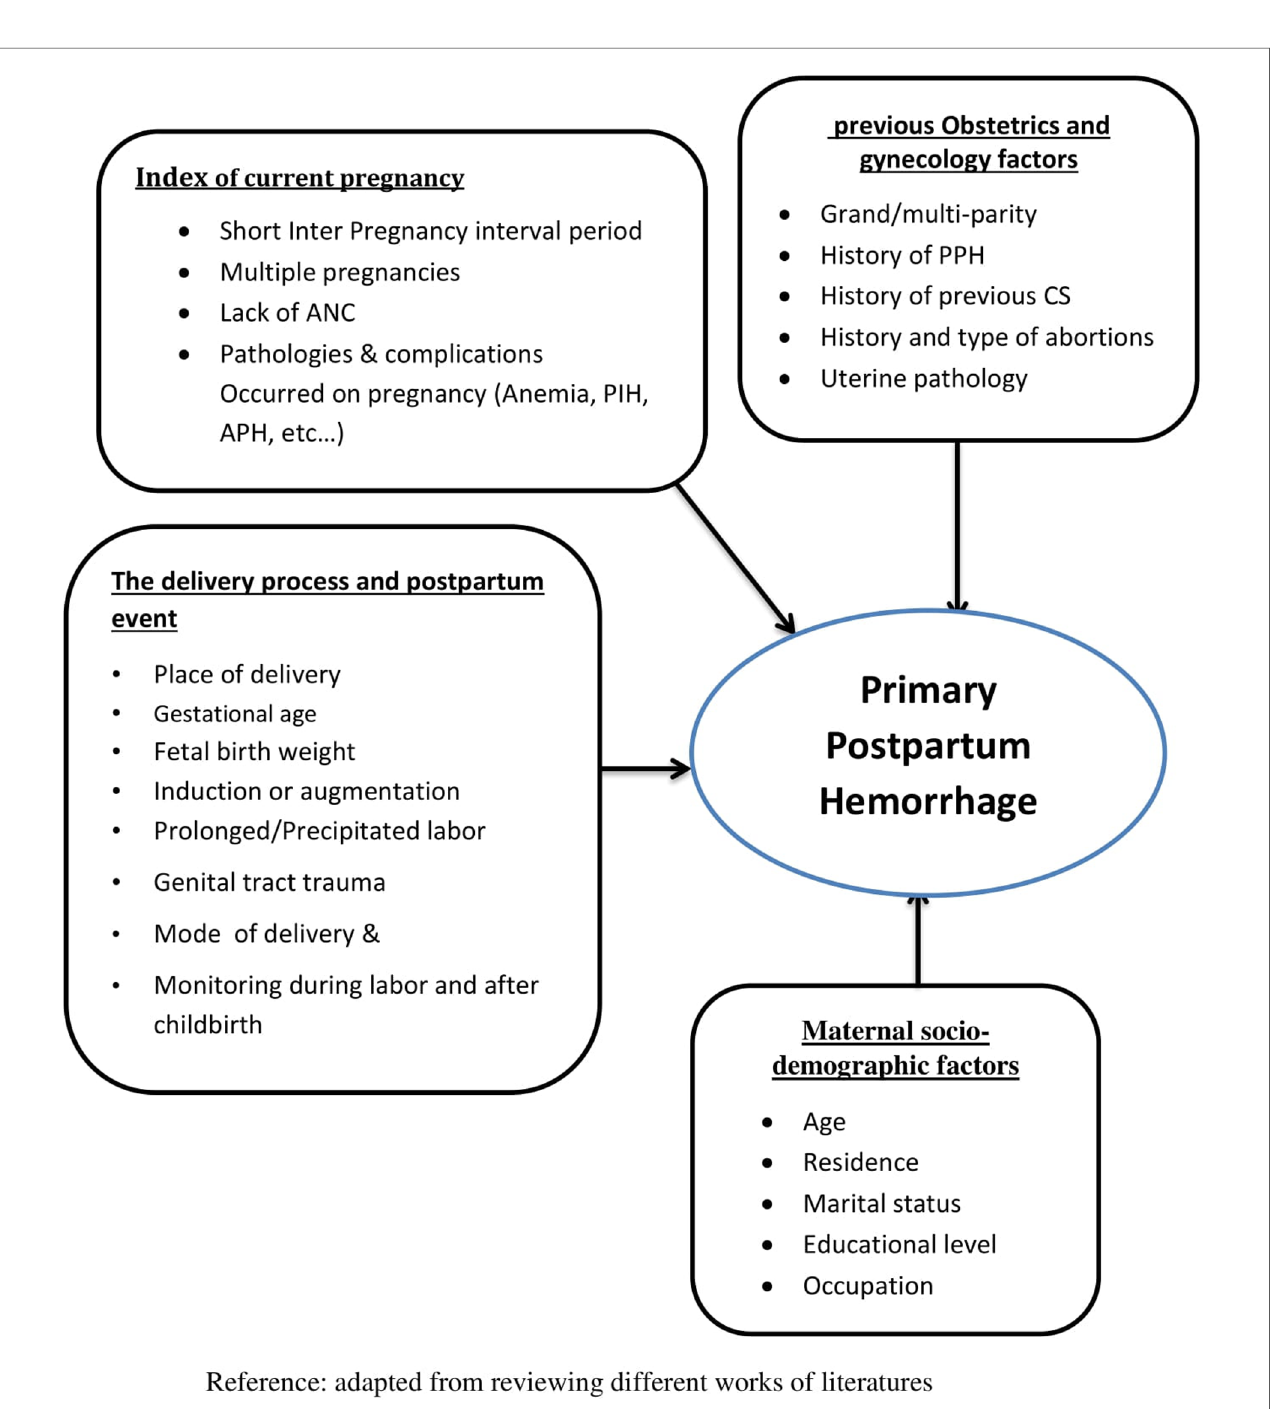
FIGURE 1 Conceptual framework on risk factors of primary postpartum